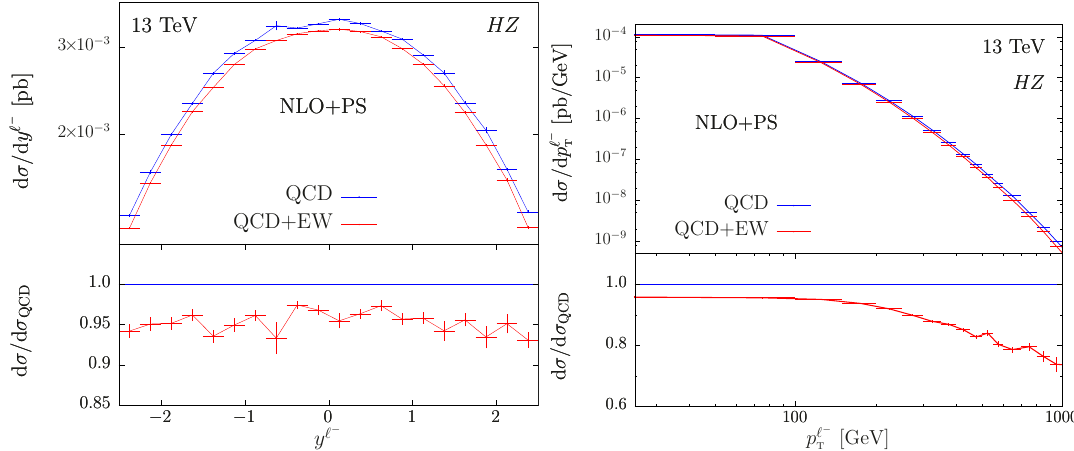
Figure 15. NLO+PS predictions for the rapidity (left) and for the transverse momentum (right) of the dressed electron in HZ production. Comparison between the full QCD+EW results and the QCD ones after the Pythia 8.1 QCD+QED shower.